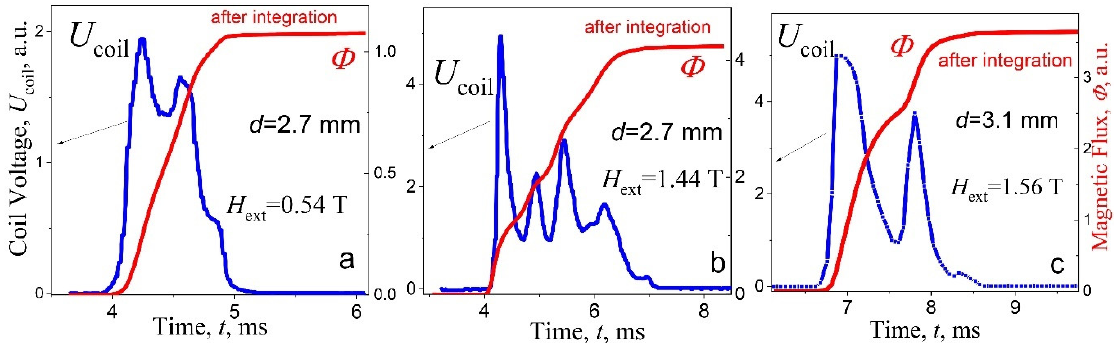
Figure 5. ( a – c ) The voltage impulses U coil ( t ) (left ordinate) and magnetic flux Φ ( t ) steps (right ordinate) at the avalanches: ( a ) first jump ( µ 0 H ext = 0.54 T), ( b ) fourth jump ( µ 0 H ext = 1.44 T) for the plate with thickness d = 2.7 mm; ( c ) fourth jump (µ 0 H ext = 1.56 T), d = 3.1 mm; ZFC, screening regime (1st quadrant), T = 2 K.